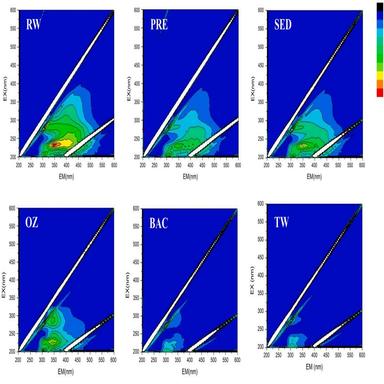
EEM components with three-dimensional maps in water samples from the DWTP.